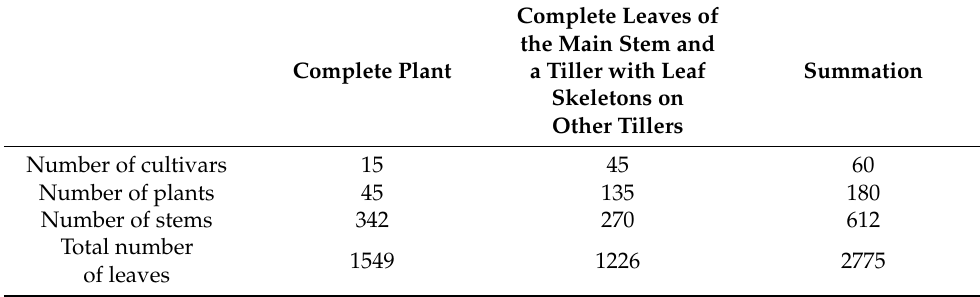
Table 1. Summary of the type and quantity of data collected.